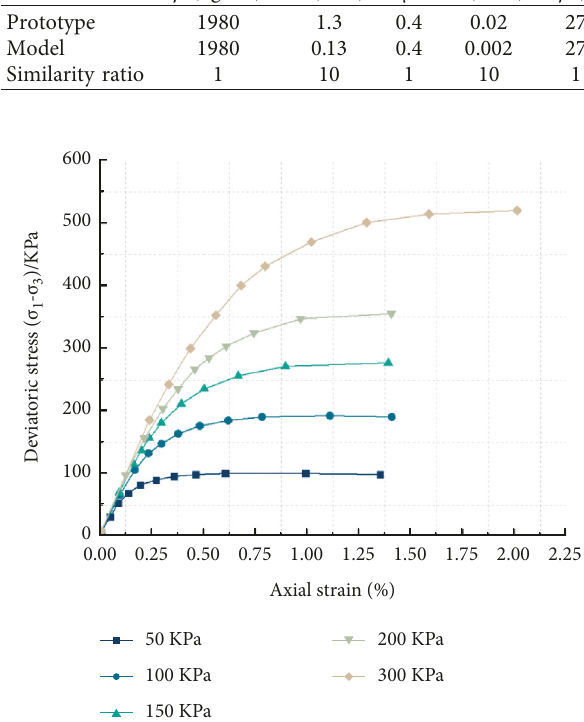
Figure 4: Stress-strain relationship under different confining